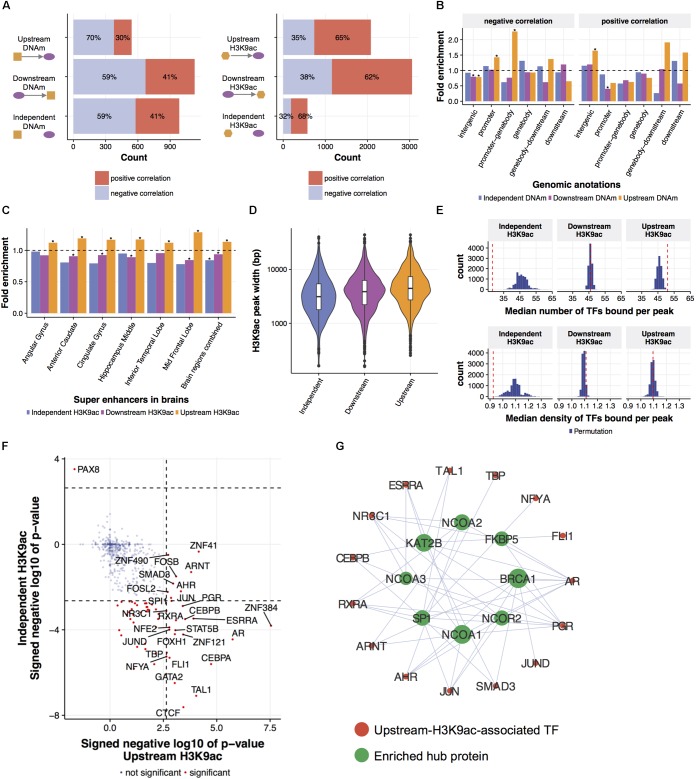
Local regulatory network predicts epigenetic modifications leading gene expression changes. (A) Predicted relationships of eQTMs and eQTHs to mRNA levels. An LRN was built for each of 3795 genes and for each AD phenotype, then DNAm and H3K9ac were classified as upstream, independent, or downstream of a given gene expression, based on the direction of the cascade of edges between the mRNA node and both DNAm and H3K9ac nodes. (B) The enrichment of predicted relationships of eQTMs to mRNA levels with genomic annotations based on gene coordinate. The asterisks represent the statistical significance based on Fisher’s exact test (FDR < 0.05). (C) The enrichment of predicted relationships of eQTHs to mRNA levels with super-enhancers in brains. The asterisks represent the statistical significance based on Fisher’s exact test (FDR < 0.05). (D) The distribution of width of eQTHs in relation to their predicted relationships to mRNA levels. (E) The TF-binding capability of eQTHs in relation to their predicted relationships to mRNA levels. The upper panel represents the median number of TF peaks overlapping with H3K9ac peaks for each predicted relationship. The lower panel represents the median number of TF peaks overlapping with H3K9ac peaks per 100 bp for each predicted relationship. The histograms represent null distributions estimated by 10,000 permutations of the relations of eQTH nodes to mRNA nodes. The red vertical lines represent observed values based on the estimated directions from eQTHs node to mRNA node. (F) The enrichment of TFs binding to eQTHs upstream or independent of mRNA levels. The dashed lines indicate the significance threshold based on Fisher’s exact test (FDR < 0.05). (G) TF-TF interaction networks around TFs binding to eQTHs upstream of mRNA nodes. For each TF, the overlap of its binding TFs and the TFs enriched in eQTHs upstream of mRNA nodes was evaluated by Fisher’s exact test (FDR < 0.05).